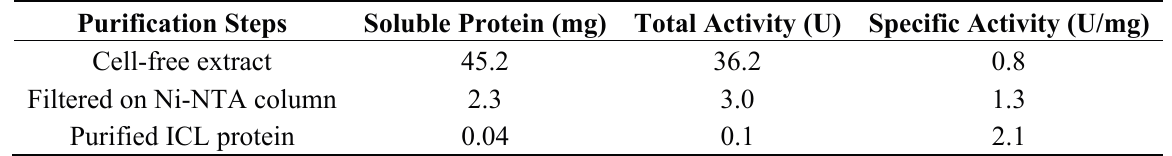
Table 1. Purification of isocitrate lyase enzyme from recombinant Escherichia coli.